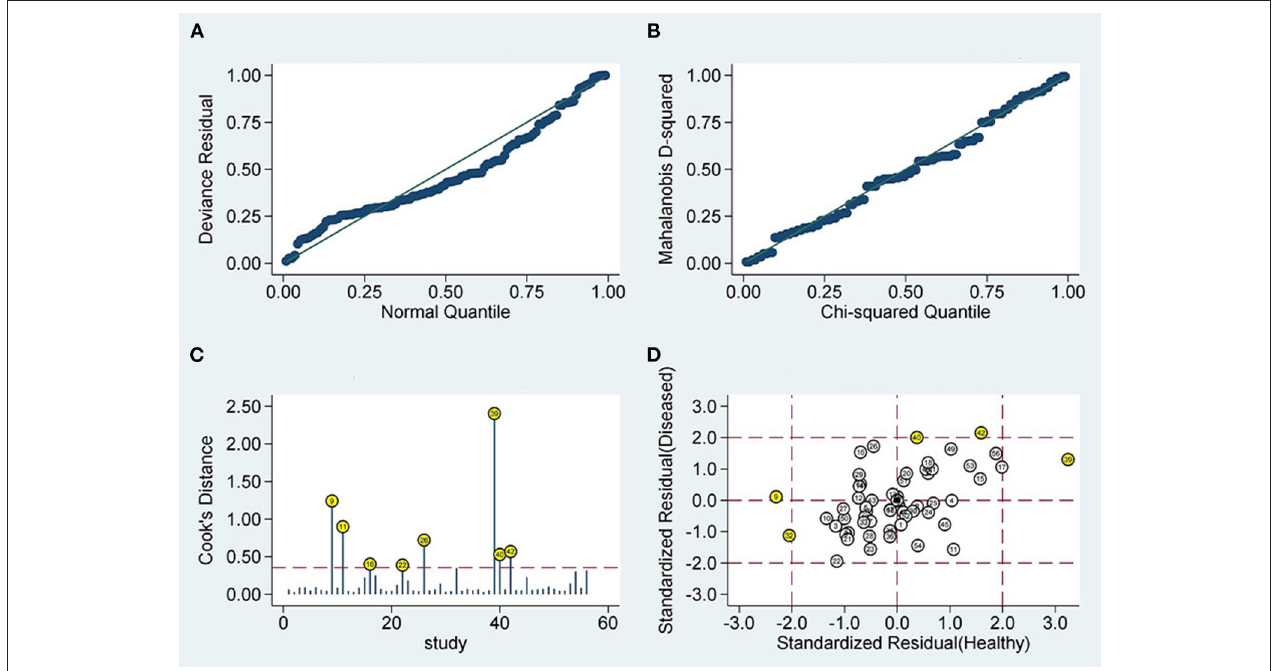
FIGURE 5 | Diagram of sensitivity analysis (A) goodness-of-fit; (B) bivariate normality; (C) influence analysis; (D) outlier detection sensitivity analysis.